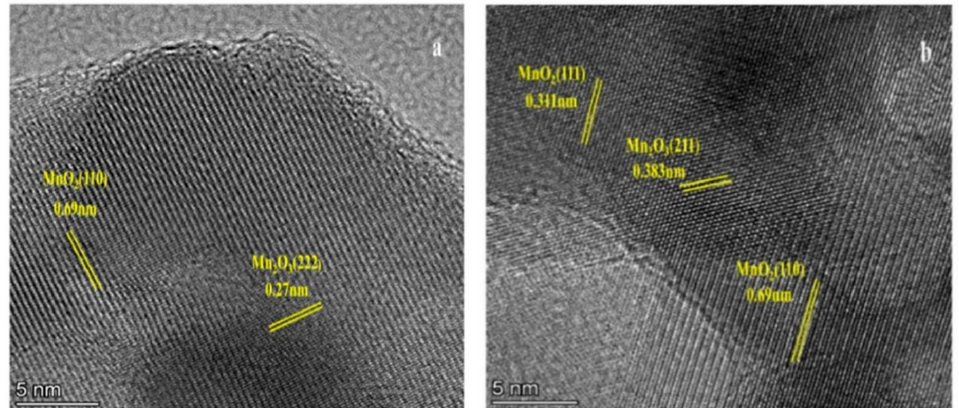
Figure 5. HRTEM patterns of MnO x /H-SAPO-34-0.1 catalyst. ( a ) plane of MnO 2 and Mn 3 O 4 ( b ) plane of MnO 2 and Mn 2 O 3.